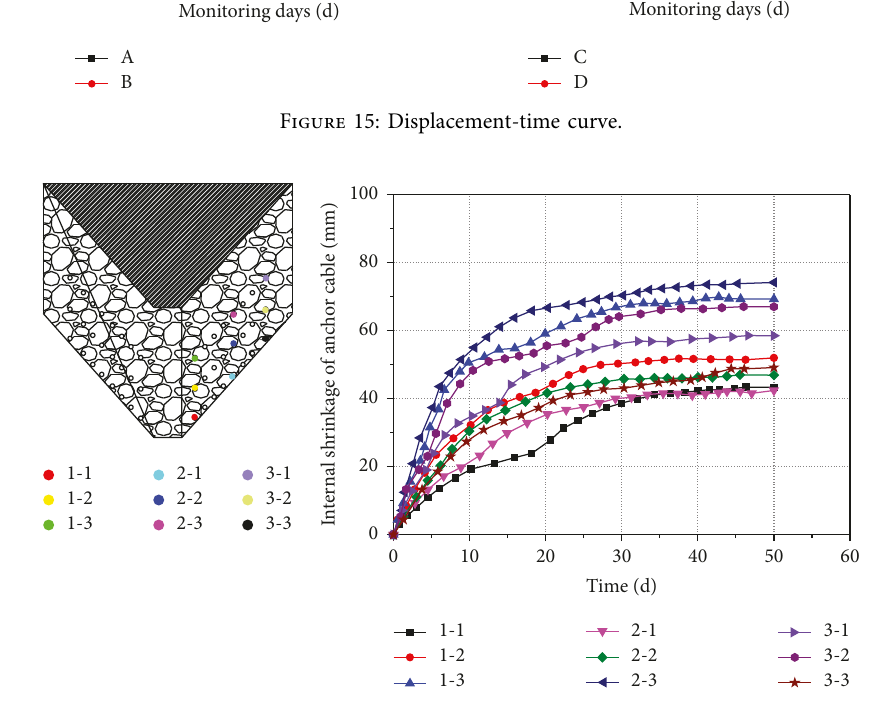
Figure 16: Monitoring of anchor cable support effect, (a) Layout of measuring points, (b) Monitoring curve of shrinkage in anchor cable.